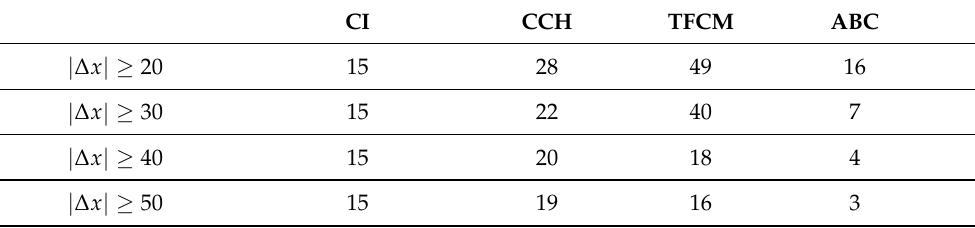
Table 6. Number of mismatches in 100